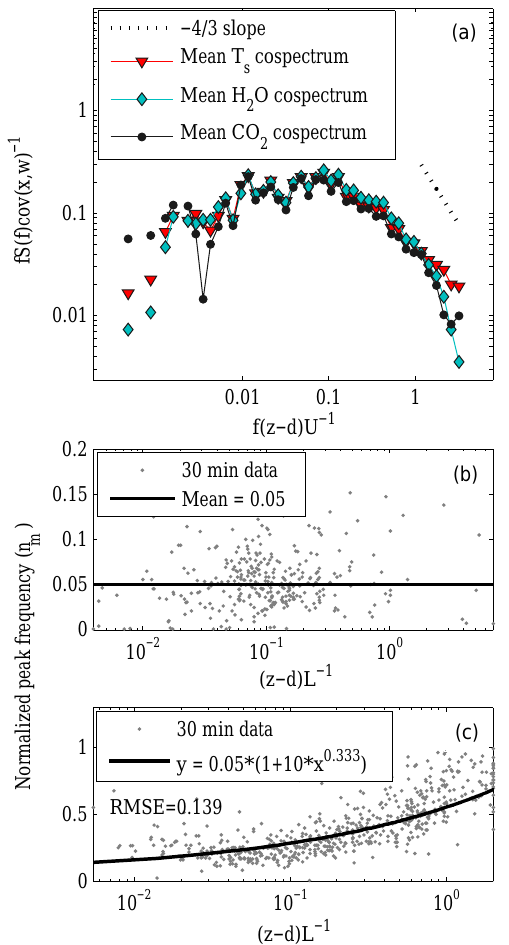
Figure 2. (a) Normalized frequency-weighted co-spectra of tem- perature, carbon dioxide, and water vapour as functions of normal- ized frequency measured on 16 July 2015, 11:00–13:30UTC + 5 (mean value of stability parameter ( z − d) L − 1 = − 0 . 023). The two following subplots show the 30min values of the normalized peak frequency n m versus the stability parameter (z − d) L − 1 in unstable conditions (b) and stable conditions (c)